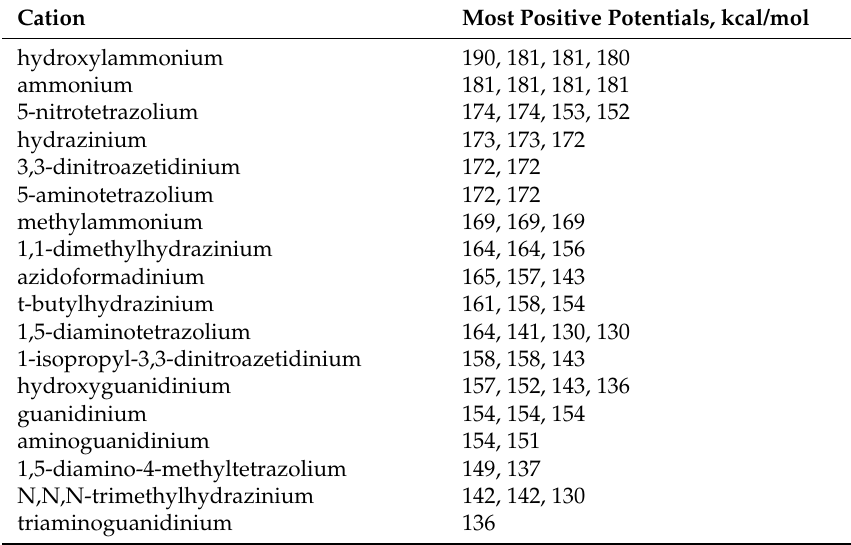
Figure 8. Computed electrostatic potential on 0.001 au cationic surface of NH 3 OH + cation. Color ranges, in kcal/mol, are: red, greater than 165; yellow, between 165 and 140; green, between 140 and 110; blue, less than 110. Circles show positions of atoms; OH group is on the left. Most positive potential is 190 kcal/mol by the OH hydrogen. Table 1. Most positive electrostatic potentials on the 0.001 au surfaces of some C,H,N,O monopositive cations.